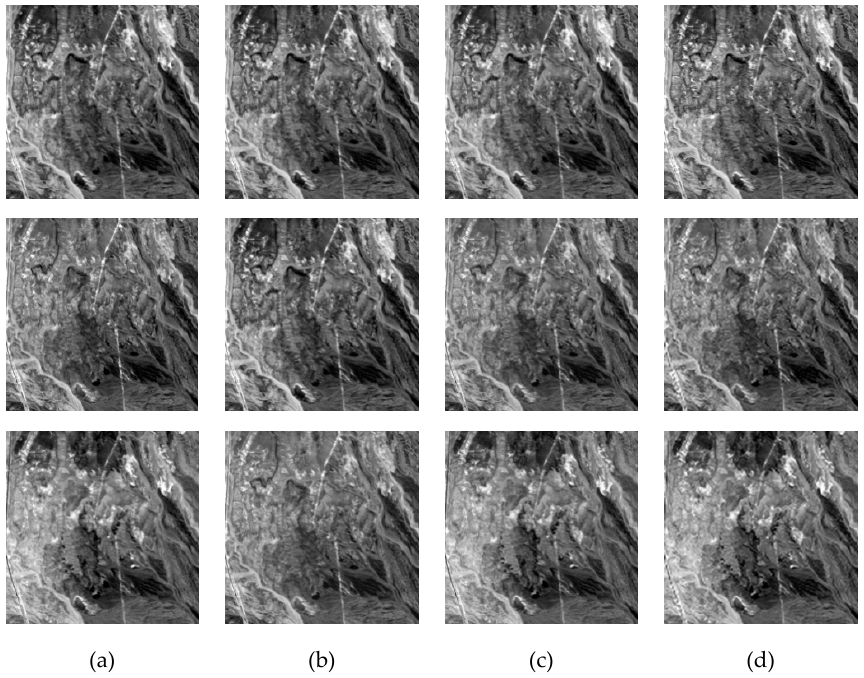
Figure 6. Spectral resolution enhancement comparison on Indian pines dataset, from top to bottom are the comparison of band 550 nm, 750 nm, and 1500 nm. ( a ) Reference HRI, spectral resolution enhancement results of ( b ) Arad method, ( c ) spectral resolution enhancement method (SREM) method, ( d ) Proposed J-SpeSpaRE method (after spatial degradation).